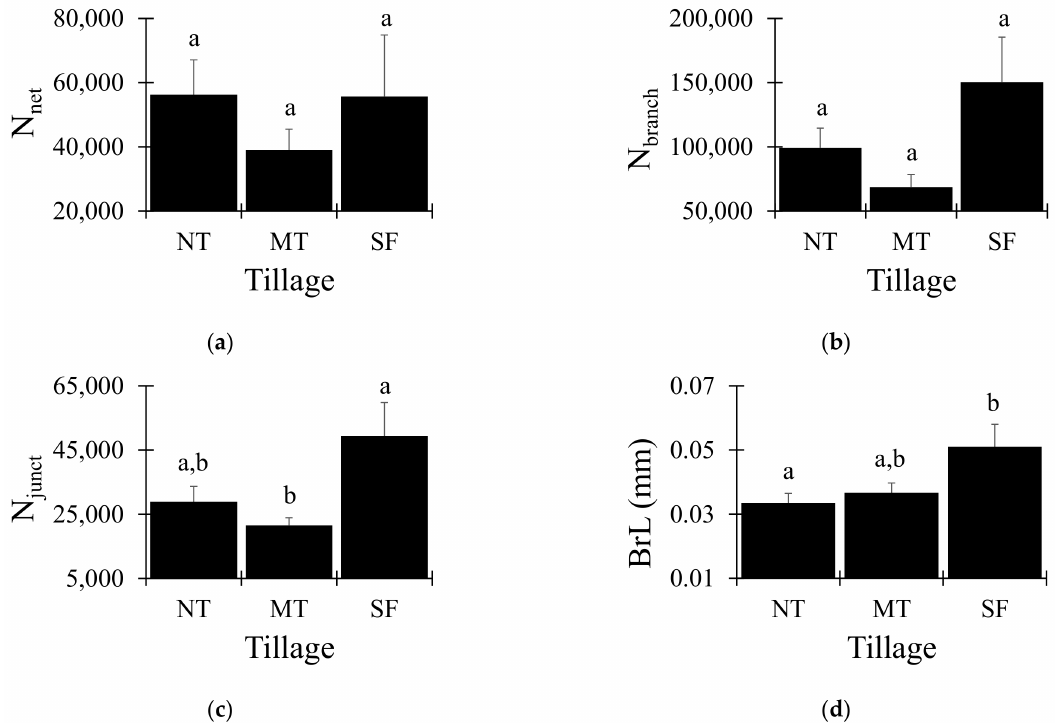
Figure 3. ( a ) Number of networks (N net ), ( b ) number of branches (N branch ), ( c ) number of junctions (N junct ), and ( d ) maximum branch length (BrL) for soil aggregates from no tillage (NT), minimum tillage (MT), and secondary forest (SF). Vertical bars represent the standard error ( n = 6). Different letters represent significant differences among management practices (Tukey’s HSD; p <